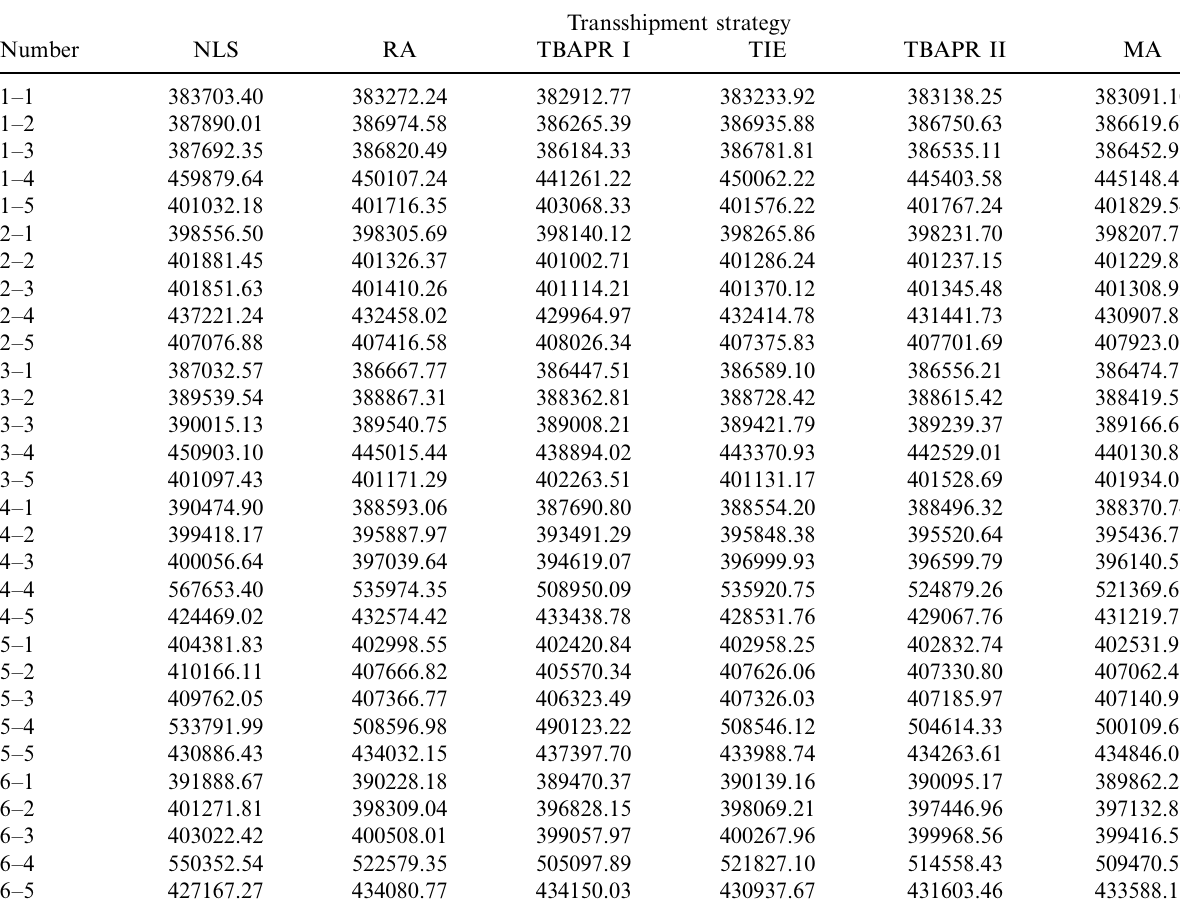
Table 2. Total cost for the three retailers system